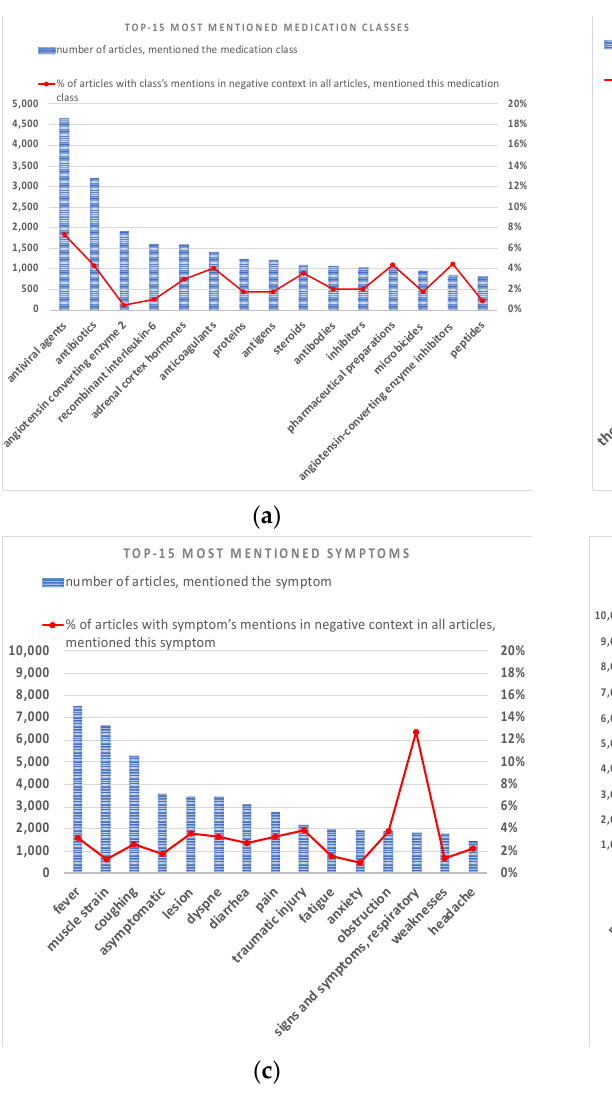
Figure 5. TOP-15 mentions and percentage of articles with negative mentions (percentage of articles with entity’s mentions in negative context with respect to all articles mentioning this entity). ( a ) medication classes (including UMLS semantic types: “Pharmacologic Substance”, “Antibiotic”, “Amino Acid, Peptide, or Protein Enzyme”, ”Biologically Active Substance”, ”Immunologic Factor”, “Chemical Viewed Functionally”; ( b ) treatments (including UMLS semantic types: “Therapeutic or Preventive Procedure”, ”Health Care Activity”, “Pharmacologic Substance”, ”Medical Device”); ( c ) signs or symptoms (including UMLS semantic groups: “Injuries and Poisonings”, “Pathologic Functions”, “Immunologic Factors”); ( d ) diagnoses (including UMLS semantic groups: “Disease or Syndrome”, “Mental or Behavioral Dysfunction”).